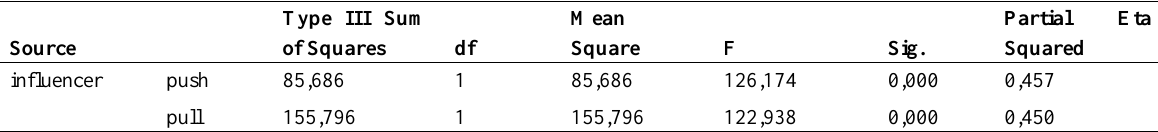
Table 6: Tests of Between-Subjects